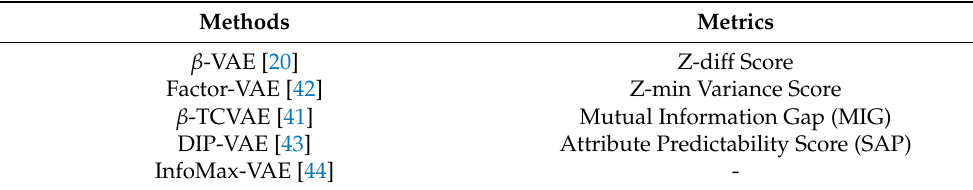
Table 1. Overview of disentanglement methods based on auto-encoding and the metric reported with each